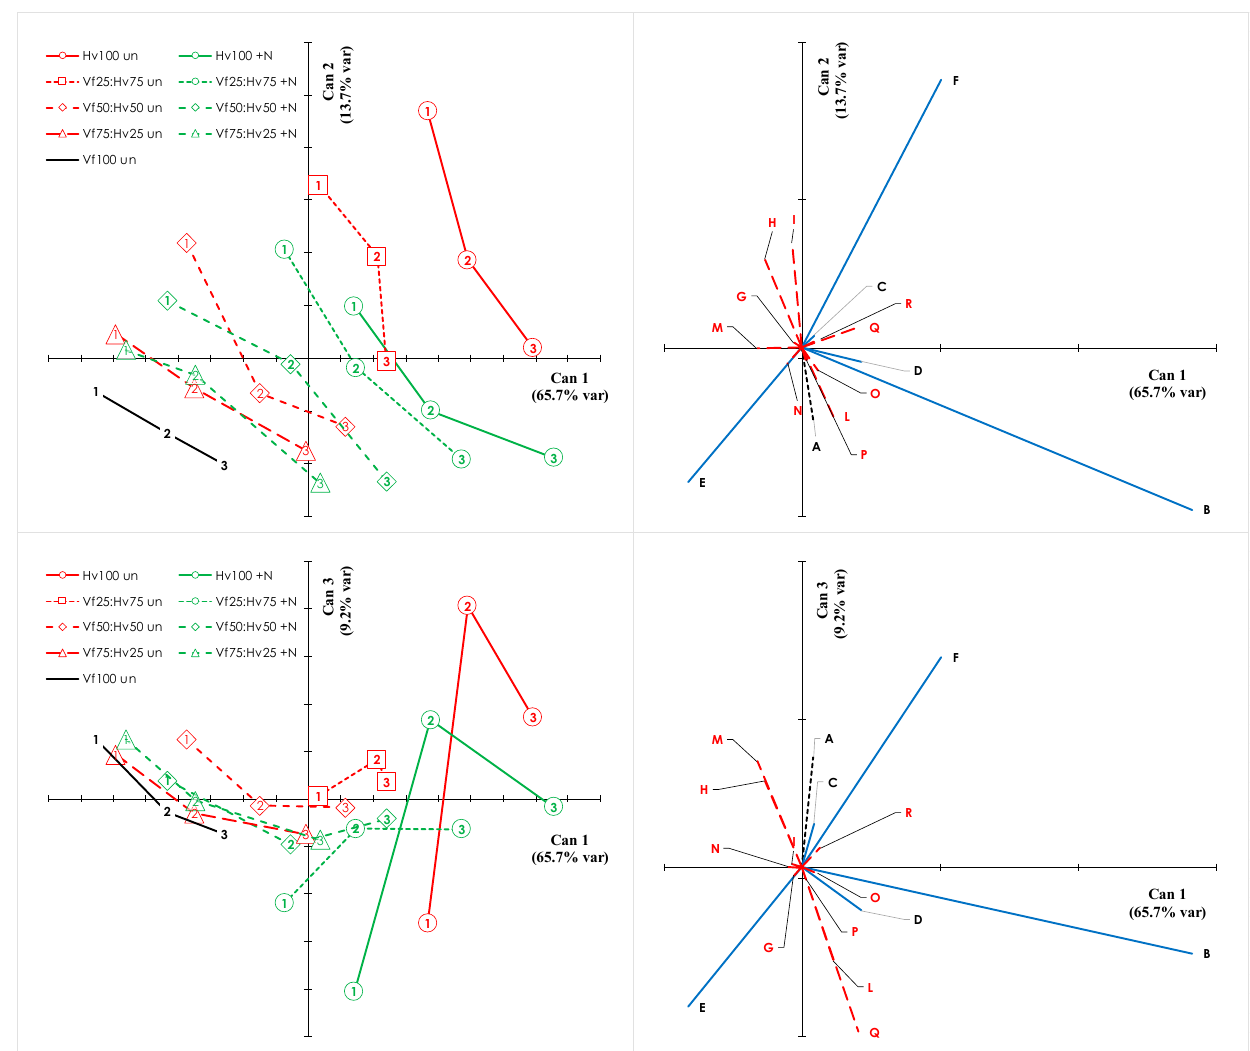
Figure 17. Canonical discriminant analysis (CDA) using standardized data with reciprocal correlation between − 0.7 and +0.7 of traits studied in the herbage and silage mixtures and pure crops, fertilized (green) or not (red). Data on the left-handed panels report points as centroid mean across replicates (±S.E.) on the canonical axes (CA) 1 and 2 ( upper panels ) and CA1 and CA3 ( lower panels ). Projection of the original variables on the CAs are reported in right-hand panels and indicated with letters as follows: weight loss from the herbage to the silage (A); dry matter (DM) (g (100 g FM) − 1 ) of the herbage (B); ether extracts (EE) (g (100 g DM) − 1 ) of the herbage (C); neutral-detergent fiber (NDF) (g (100 g DM) − 1 ) of the herbage (D); water-soluble carbohydrates (WSCs) (g (100 g DM) − 1 ) of the herbage (E); WSC to CP ratio of the herbage (F); ether extracts (EE) (g (100 g DM) − 1 ) of the silage (G); ash (g (100 g DM) − 1 ) of the silage (H); neutral-detergent fiber (NDF) (g (100 g DM) − 1 ) of the silage (I); acid-detergent fiber (ADF) (g (100 g DM) − 1 ) of the silage (L); acid-detergent lignin (ADL) (g (100 g DM) − 1 ) of the silage (M); water-soluble carbohydrates (WSCs) (g (100 g DM) − 1 ) of the silage (N); propionic acid (g (100 g DM) − 1 ) (O); butyric acid (g (100 g DM) − 1 ) (P); isovaleric acid (g (100 g DM) − 1 ) (Q); acetic acid to lactic acid ratio (R). The percentages of the total variance explained by each canonical axis are shown in brackets. Lines starting from “0;0” represent the vectors of each determinant (blue and continuous or hatched only for visualization purposes). Please note that the CDA vectors do not represent perpendicular directions through the space of the original variables. The unit of measure is the same for both axes (3.0 units) in all panels.